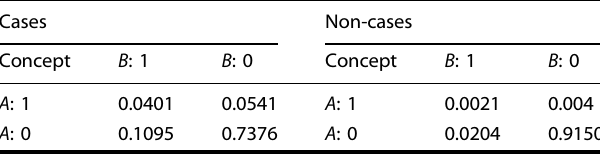
Table 6. Contingency tables for the structured-unstructured pair “ Other, mixed, or unspeci fi ed drug abuse, unspeci fi ed use ” ( A ) and “ suicide attempts ” ( B ).